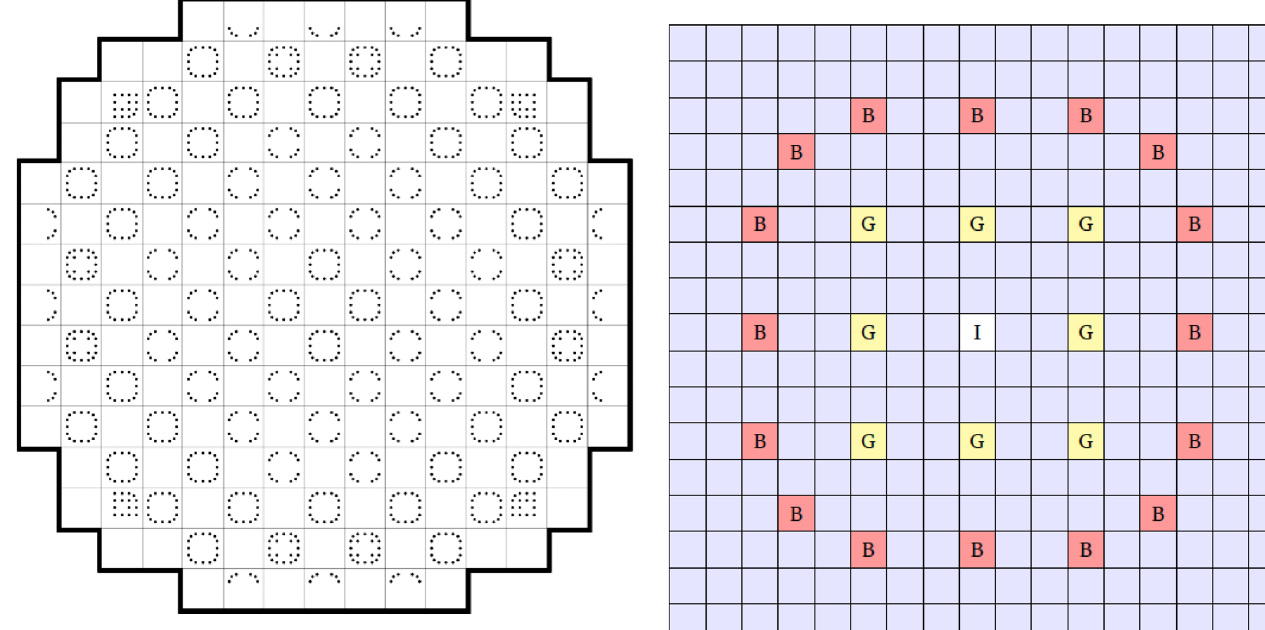
Fig. 2. Number and positions of pyrex pin at cycle 1.